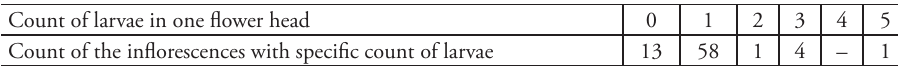
Table 3. Abundance of Larinus vulpes larvae in flower heads of Echinops sphaerocephalus (Khomutovskyi Step Reserve, 30–31.07.1982;